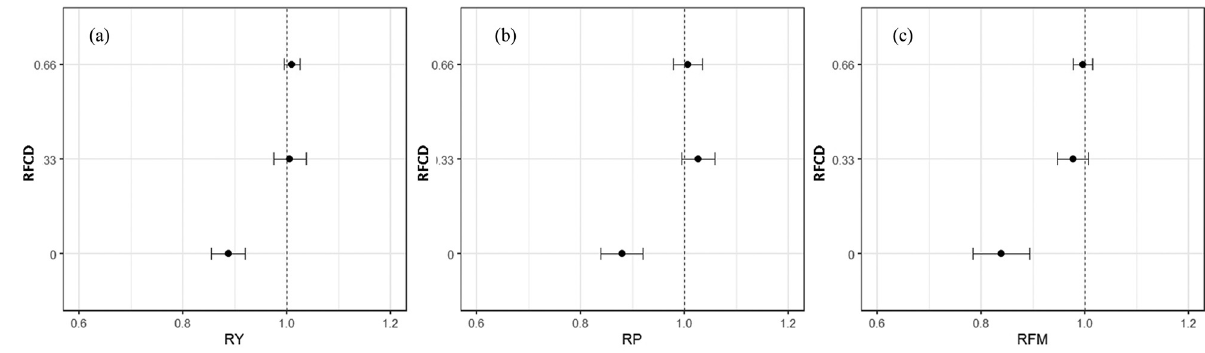
Figure 5: High - altitude subgroup e ff ect of tobacco RY ( a ) , RP ( b ) , and RFM ( c ) responding to RFCD of tobacco.